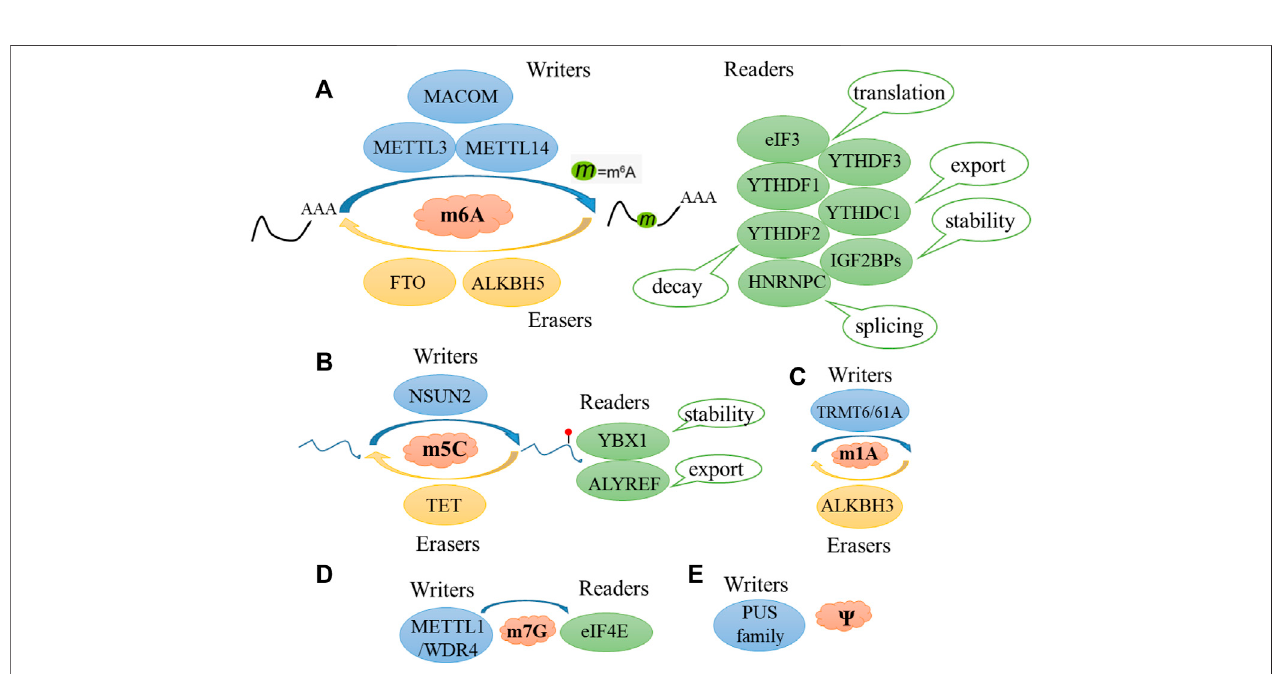
FIGURE 2 | Major classes of RNA modi fi cation. Schematic diagram of m 6 A (A) , m 5 C (B) , m 1 A (C) , m 7 G (D) , Ψ (E) , and regulated by methyltransferase (writers), demethylases (erasers), and some speci fi c proteins